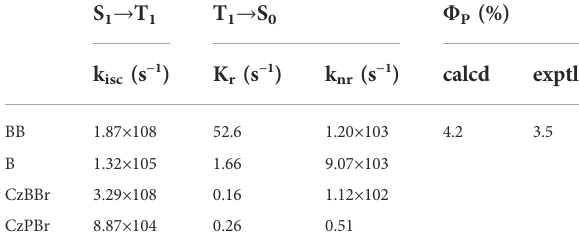
TABLE 2 The optical physical property parameters of studied molecules. S → T 1